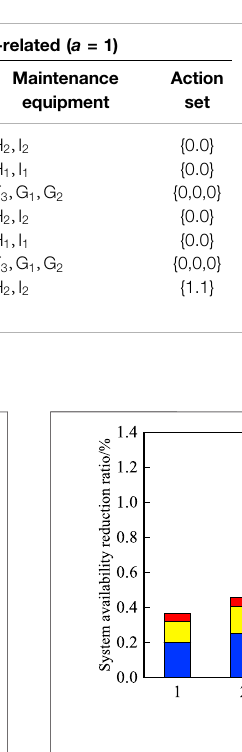
FIGURE 12 | Change rate curve of maintenance cost. FIGURE 13 | Impact of different weather accessibility on system